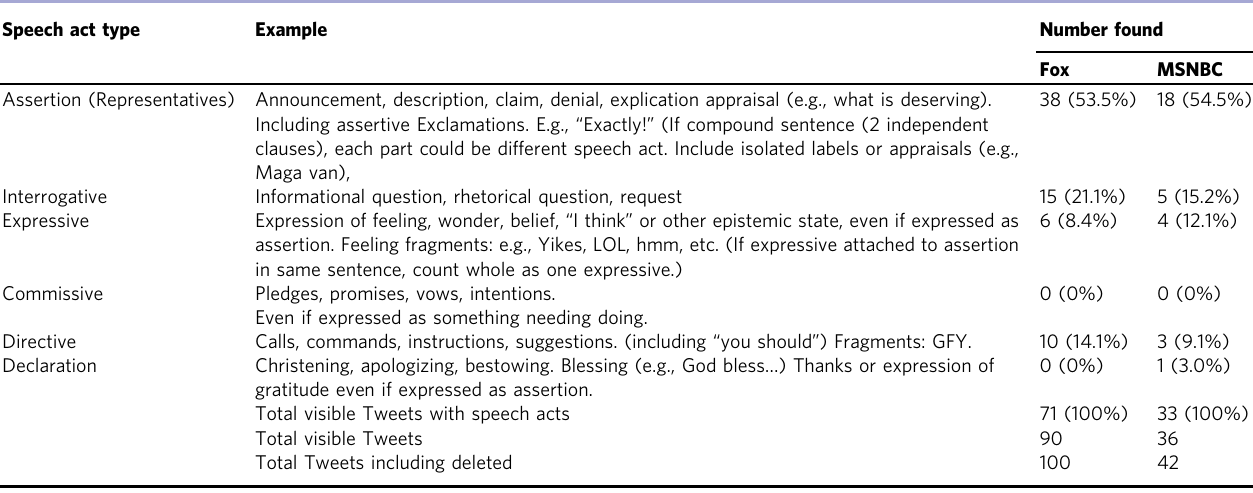
Table 1 Speech act types and their distribution among fi rst speech act types per tweet. Speech act type